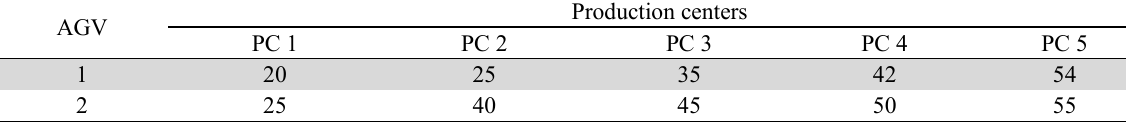
AGV-Production center travel-time matrix for FMS layout